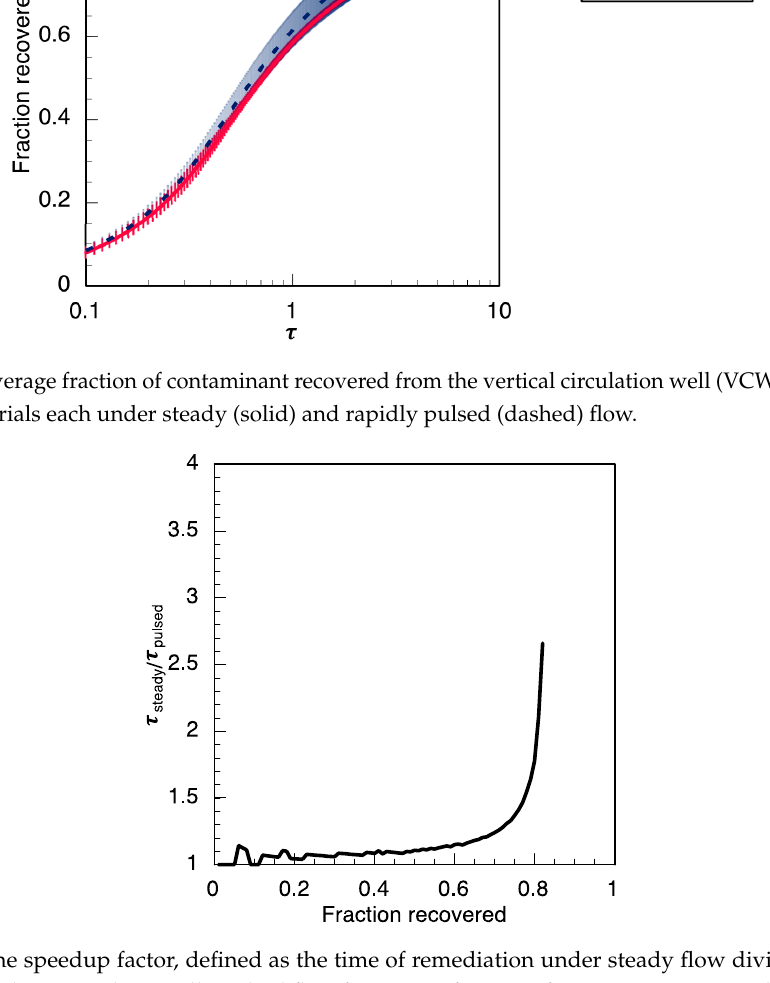
Figure 3. The speedup factor, defined as the time of remediation under steady flow divided by the time of remediation under rapidly pulsed flow for a given fraction of contaminant removed, calculated based on the averaged data from Figure 2. The cleanup factor shows how many times faster the rapidly pulsed flow would achieve a given fraction recovered than the steady flow.